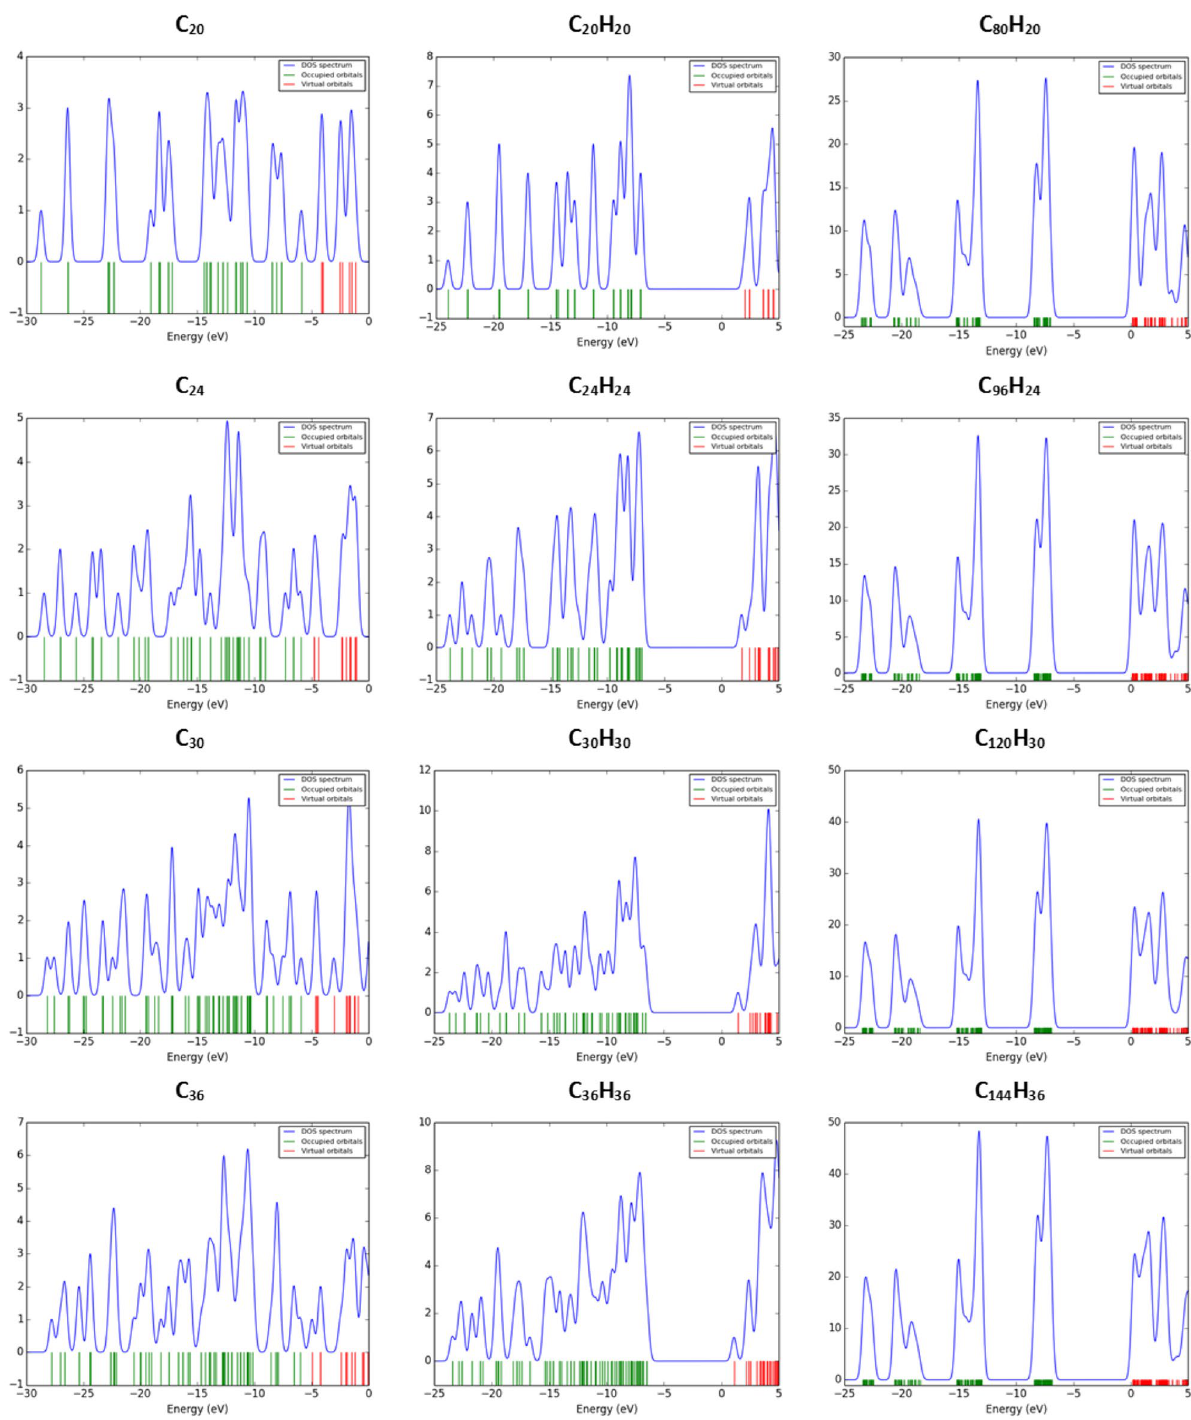
Figure 9. The density of the states’ diagrams in the fullerene, fullerane, and fulleryne structures, respectively. The density of states diagrams for the investigated nanocages are obtained using GussSumm software. Fullerenes have a larger electron affinity due to their negative LUMO levels, but fulleranes do not tend to capture electrons, due to a positive LUMO level. By considering the DOS of fullerynes, we see that their reactivity is between fullerenes and fulleranes, and unlike these two groups, as their size grows, their reactivity